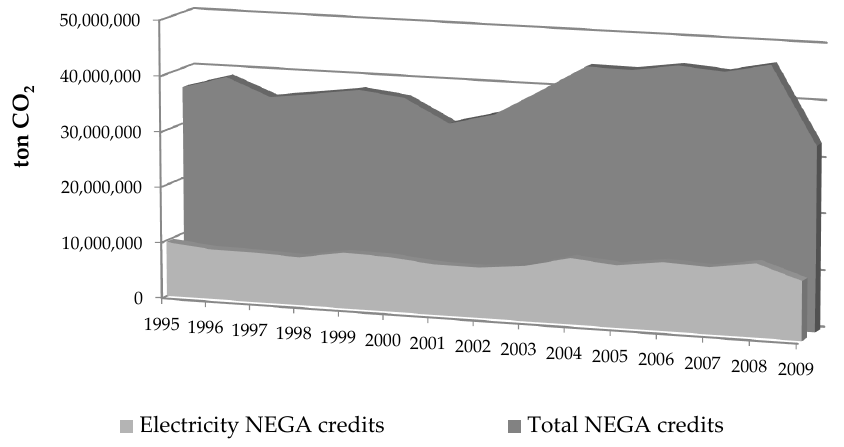
Figure 3. NEGA credits in the Swedish exports (total NEGA) and of which embodied NEGA credits from electricity consumption (electricity NEGA).